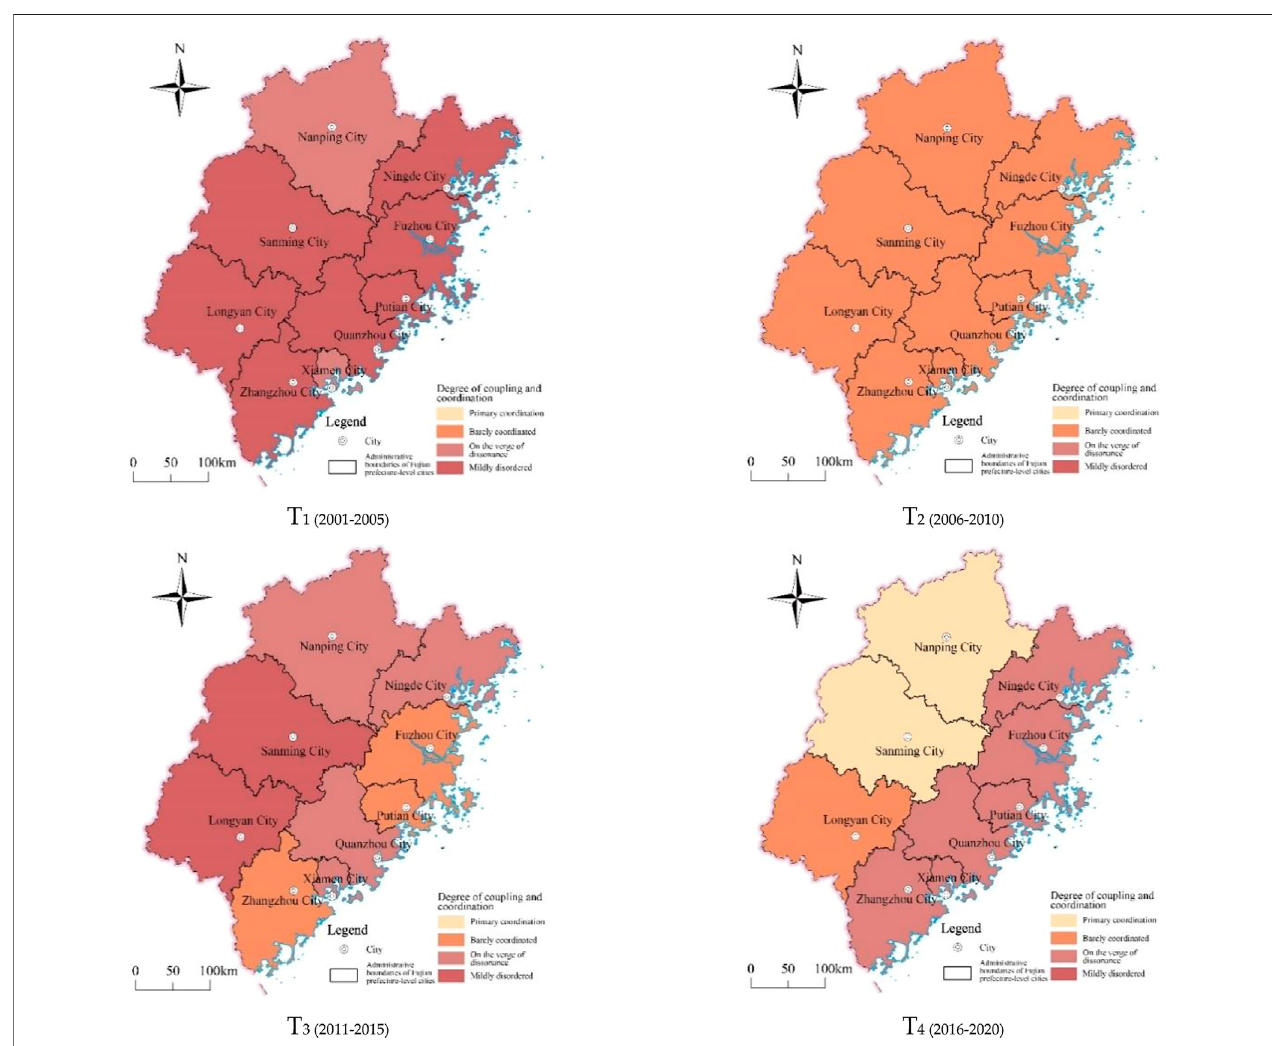
FIGURE 3 | Spatial distribution of coupling coordination degree between carbon emissions and economic growth in prefecture-level cities of Fujian Province.